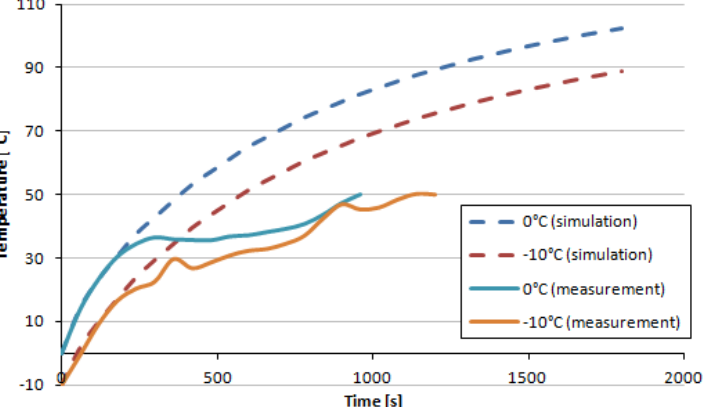
Figure 12. The temperature of the radiator surface vs. time for a frequency of 40 kHz and initial temperatures of 0 °C and −10 °C—simulation (solid lines) and measurement (dashed lines).